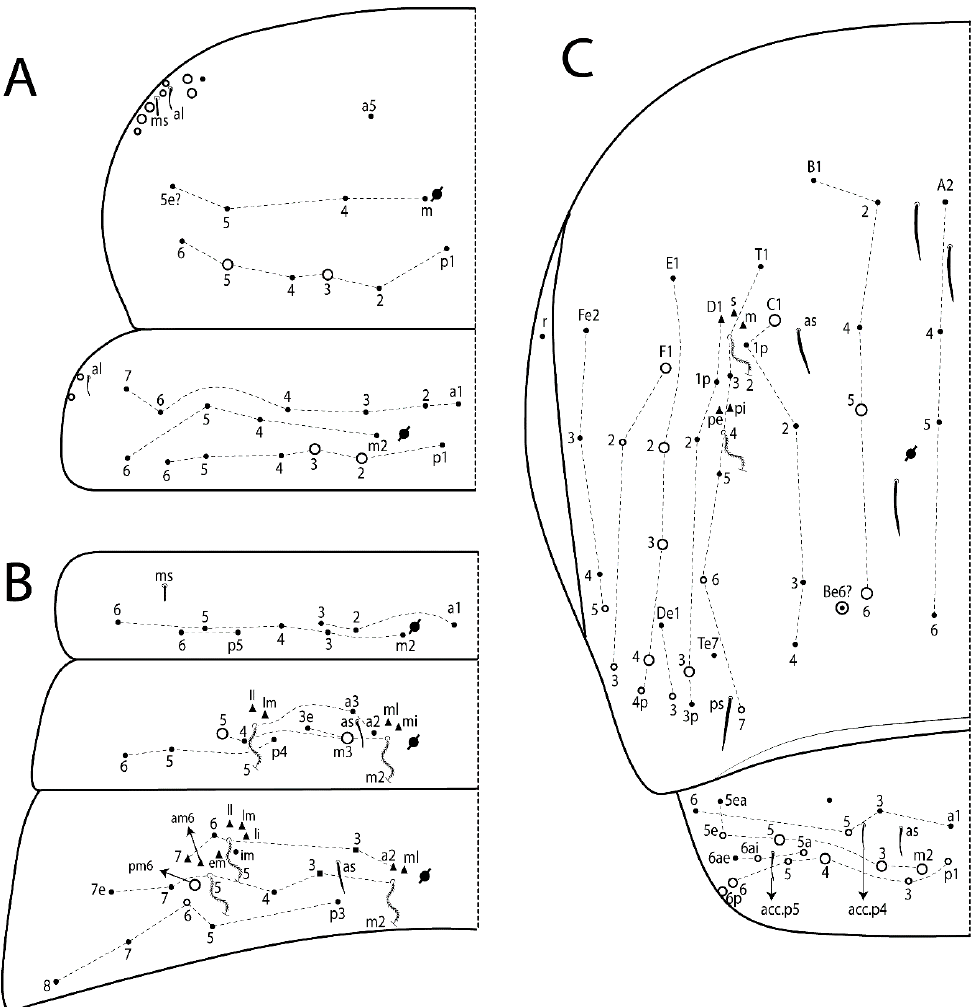
Figure 23. Pseudosinella labruspinata sp. nov.: dorsal chaetotaxy. ( A ) Th II–III; ( B ) Abd I–III; ( C ) Abd IV–V.